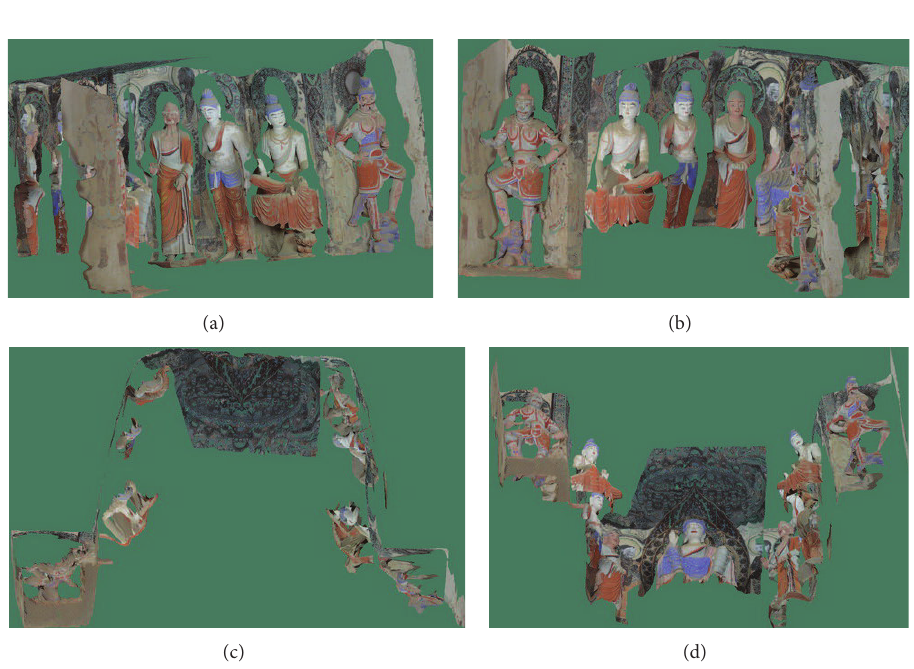
Figure 9: The integrated 3D model: (a) left view, (b) right view, (c) top view, and (d) bottom